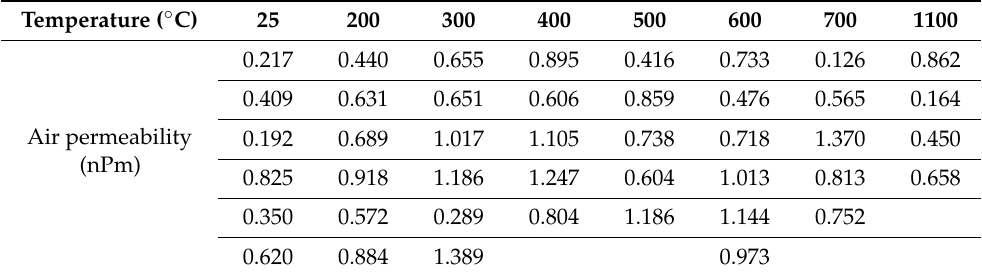
Table A1. The data of air permeability.